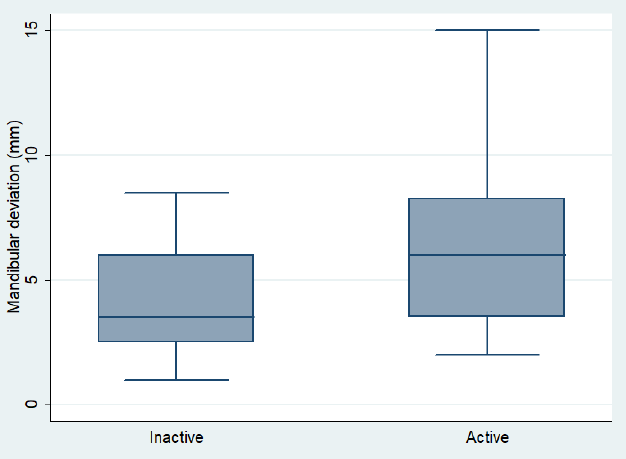
Figure 5. Mandibular deviation 95% confidence intervals (CIs) in active and inactive UCH pa- tients.